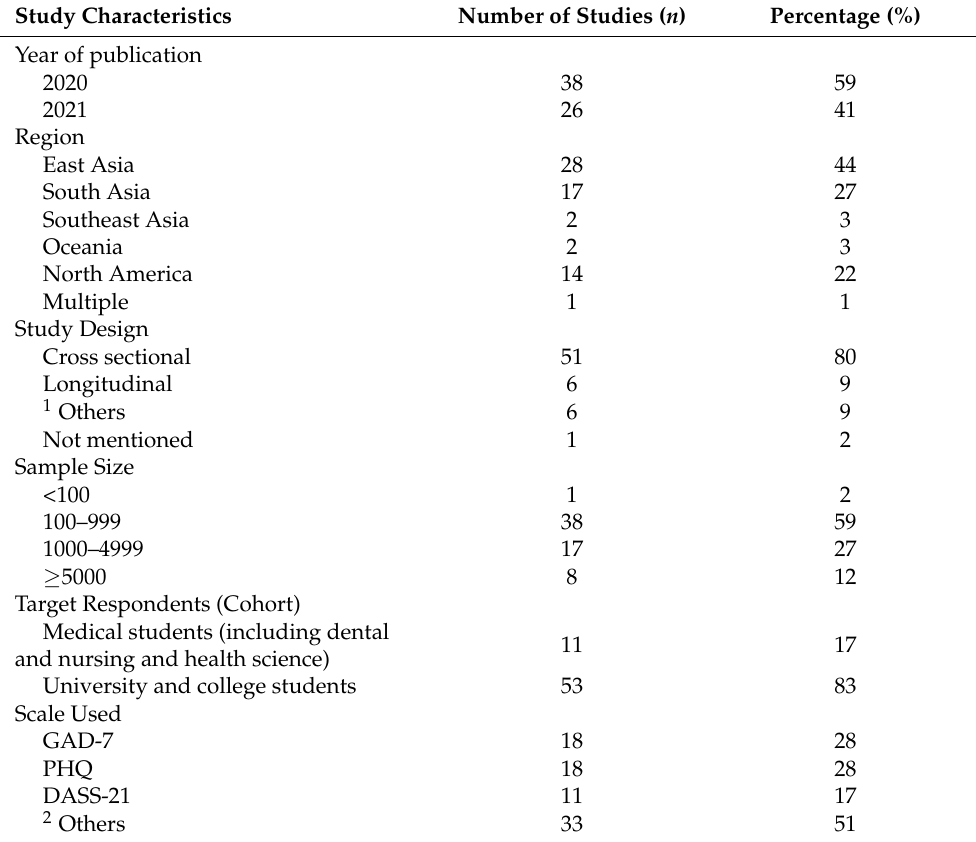
Table 1. Description of Published Research Articles Included in Scoping Review (N =